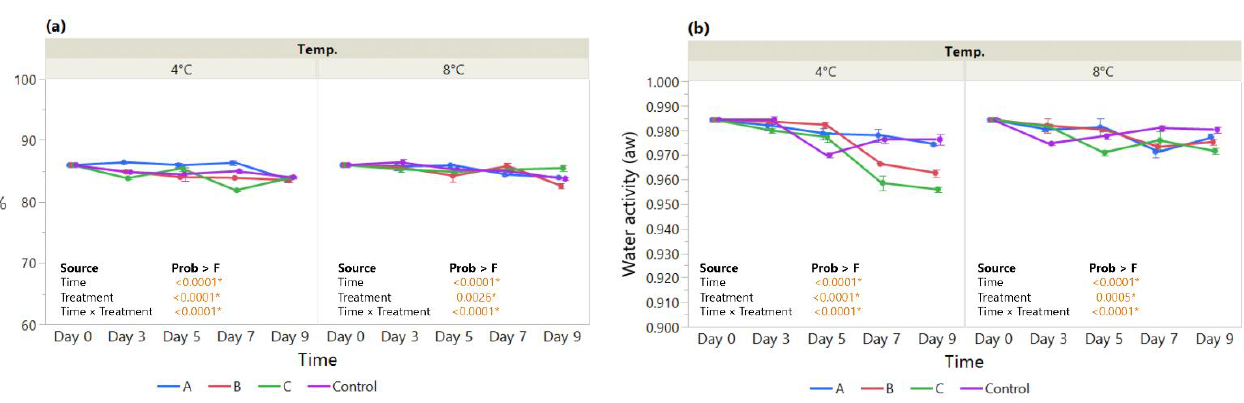
Figure 5. The effect of coating treatment on apple slices ( a ) Dry matter (DM%) and ( b ) Water activity (a w ) during a 9-day storage period at 4 °C and 8 °C. The p -values for the effects of Treatment (coating), Time and Interaction Treatment × Time are shown. Data are means ± SEM (n = 3). Asterisk (*) indicates significance ( p < 0.05*).